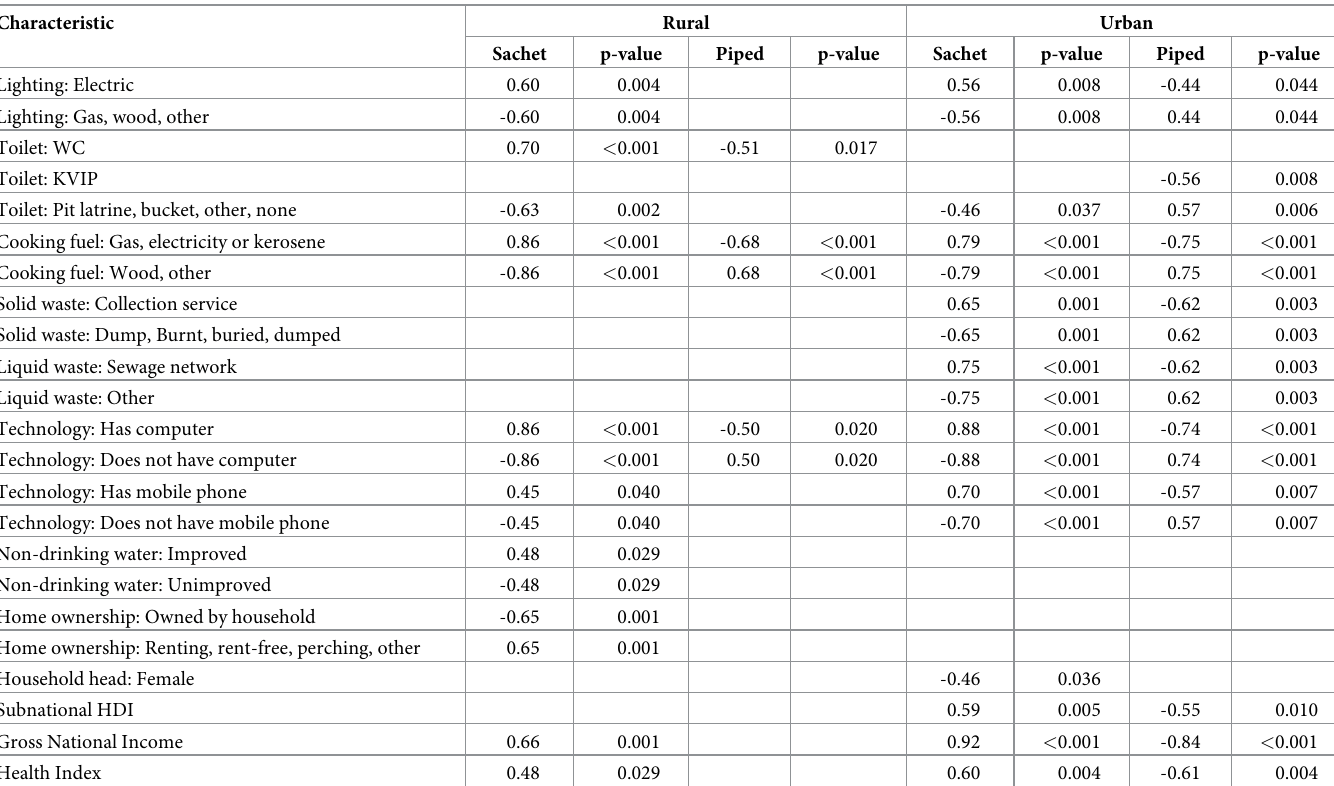
Table 4. Correlation between household characteristics and consumption of water types at the regional level. Only values significant at the 5% level are reported.